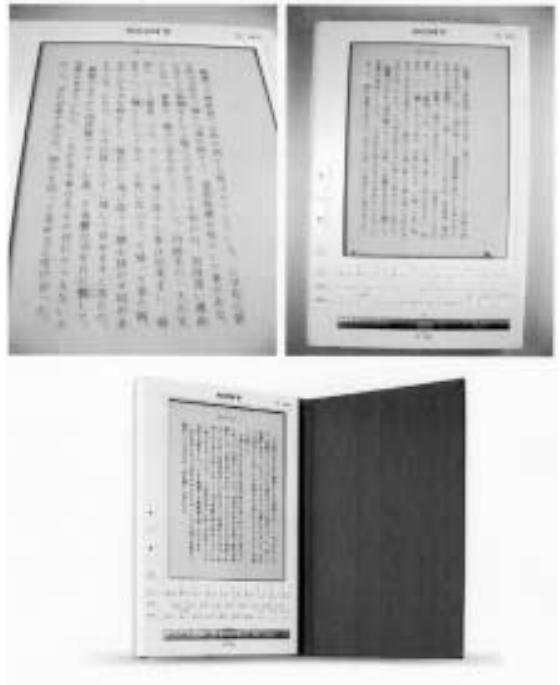
Fig. 6 Photograph of Sony Corporation LIBRIé that uses the elec- trophoretic ink technology of